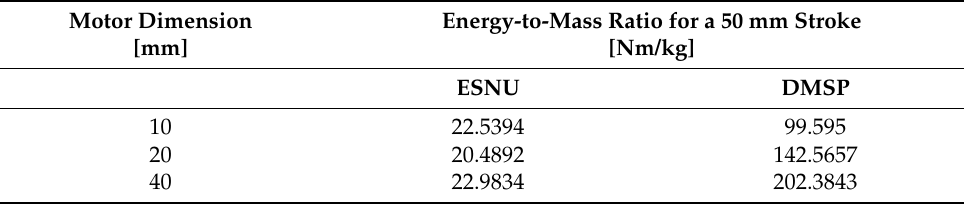
Figure 6. Energy developed by: ( a ) ESNU pneumatic cylinders; ( b ) DMSP pneumatic muscles. Equations (21)–(23) represent the calculation formulae of the energy-to-mass ratios Figure 7 shows the variation in the energy-to-mass ratios versus stroke for the six for the three studied pneumatic cylinders: pneumatic motors and Table 6 presents the values of these ratios for a 50 mm stroke. Table 6. Energy-to-mass ratios of the studied pneumatic